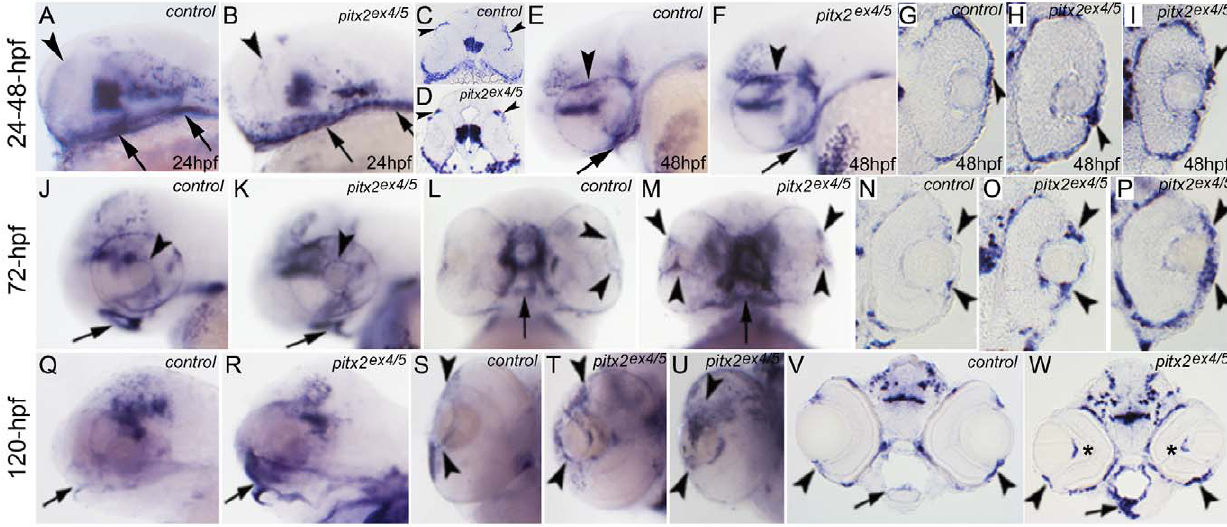
Figure 3. In situ hybridization with pitx2-exon5 antisense riboprobe in control and morphant embryos. The pitx2 antisense riboprobe comprising exon 5 sequence detects wild-type and abnormally spliced pitx2 ex4/5 transcripts. Images of whole mount embryos ( A–F , J–M and Q–U ) and sections ( G–I , N–P and V, W ) are shown for embryonic stages of 24-hpf ( A–D ), 48-hpf ( E–I ), 72-hpf ( J–P ) and 120-hpf ( Q–W ). Please note abnormal pitx2 transcripts around the developing eye (arrowheads in B, D ) and pharyngeal arches (arrows in B ) in morphants at 24-hpf, which is similar to pitx2 expression in control embryos ( A , C ). Staining for pitx2 positive cells in morphant embryos at 48-, 72- and 120-hpf identifies abnormal patterns during ocular and craniofacial development in comparison to pitx2 expression in control embryos ( E–W ). In terms of ocular patterns, some 48- and 72-hpf morphants demonstrate an accumulation of pitx2 transcriptionally active cells in the anterior segment of the eye (arrowheads; images for whole mount and sections from two different pitx2 ex4/5 morphant embryos at 48-hpf ( F, H, I ) and 72-hpf ( K, M, O, P ) in comparison to control 48- hpf ( E,G ) and 72-hpf ( J, L, N ) are shown). In 120-hpf eyes, a disorganized pattern of pitx2 positive cells continues to be observed in pitx2 ex4/5 morphant embryos (arrowheads in T , U , two different morphant embryos are shown, and W ) in comparison to pitx2 expression in control embryos ( S, V ); in addition to the abnormal pattern in the anterior structures, an increased signal behind the lens corresponding to the hyaloid vasculature is also observed (asterisks in W ). With regards to craniofacial development, in 72-hpf morphant embryos, strong staining is observed around the malformed oral cavity and arches with the level of expression similar to control pitx2 expression (arrows in J–M ); at 120-hpf, pitx2 transcripts continue to be strongly expressed in the malformed pharyngeal arches (arrows in R and W ) while expression of wild-type pitx2 is downregulated in control 120-hpf embryos (arrows in Q and V ).